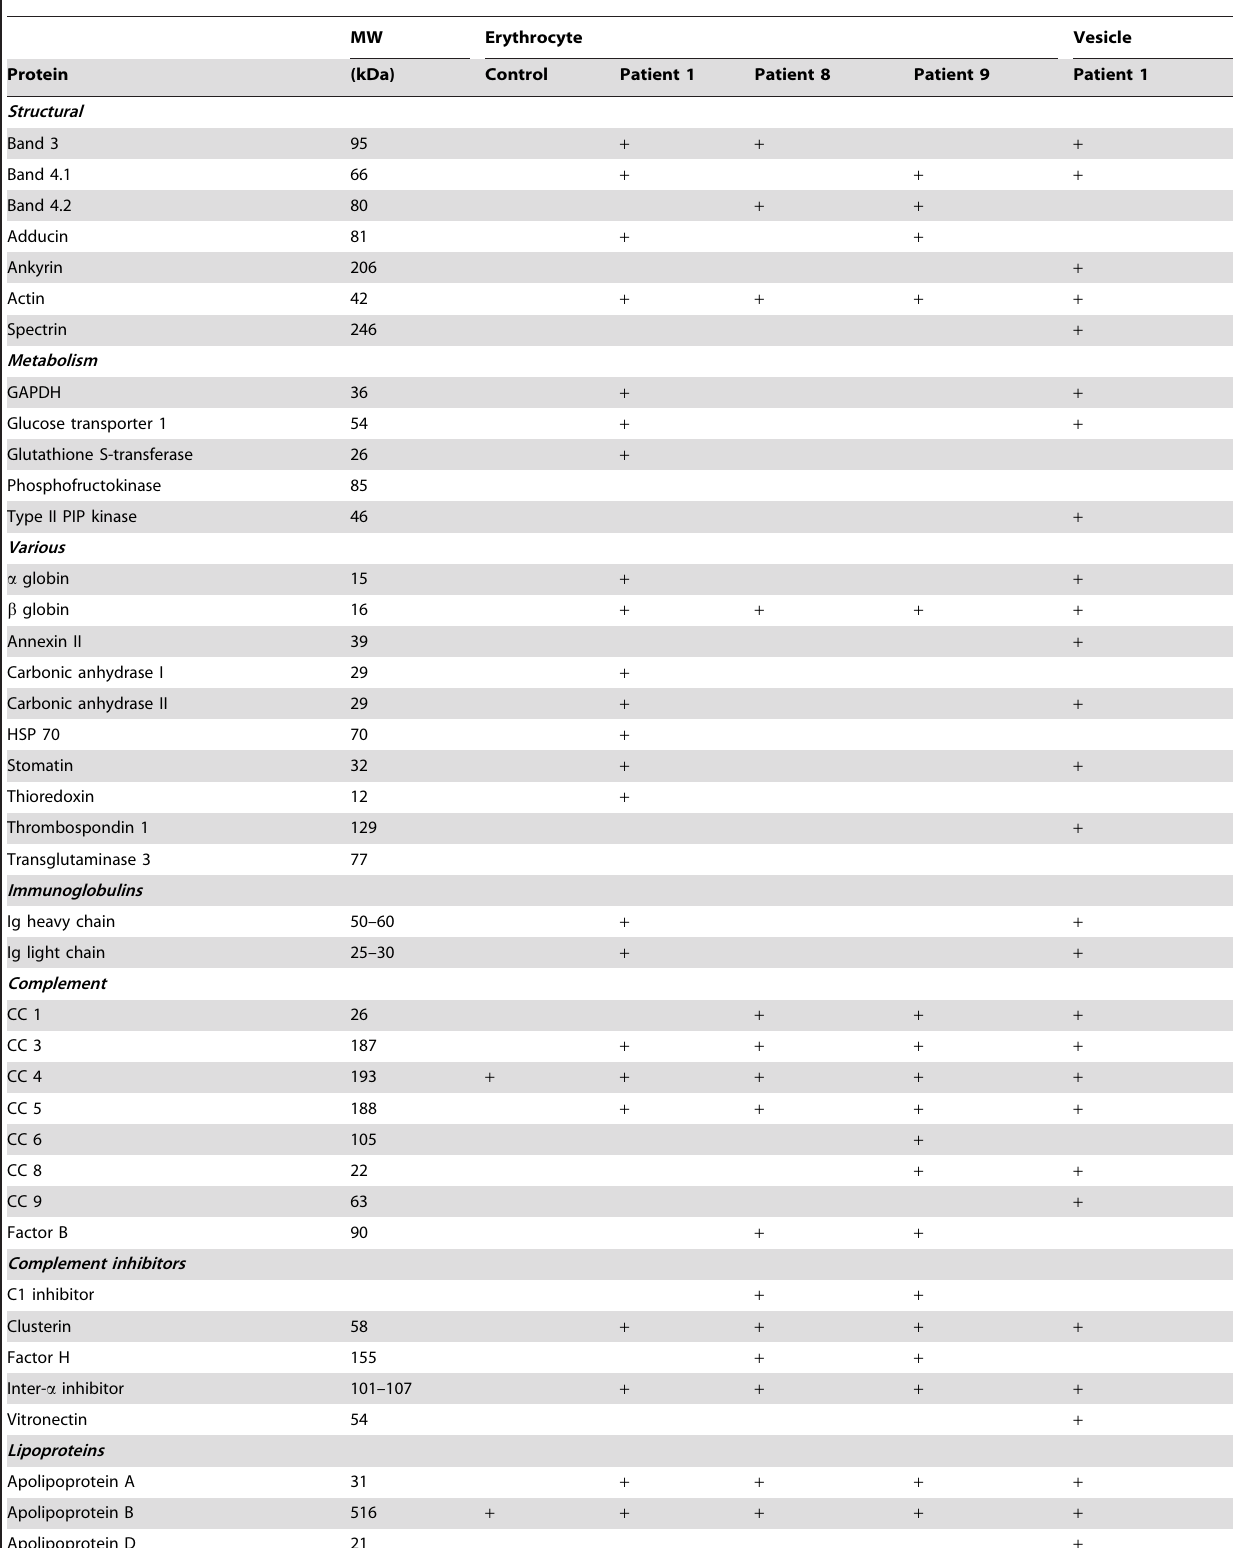
Table 2. Summary of proteins identified by proteomics analyses of erythrocyte/vesicle immunoprecipitations using